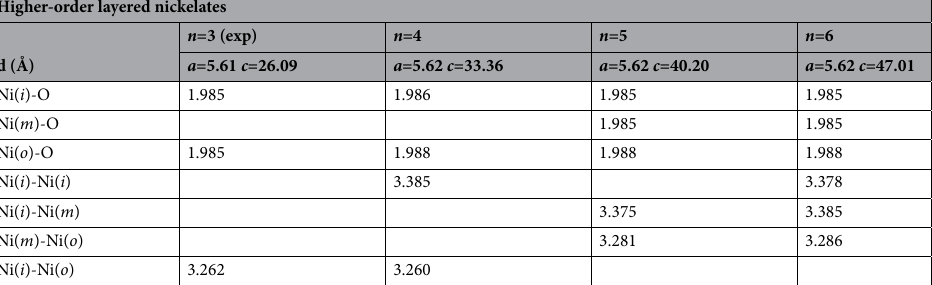
Table 1. Lattice parameters and bond lengths (in Å) obtained from the structural relaxations for La-based 4 6 layered nickelates (La 4 Ni 3 O 8 = 438, n n = − 6 ). The experimental structural data for the n La 7 Ni 6 O 14 = 7614, n = Labels i , m , and o denote the inner-, mid-, and outer-layers, respectively.